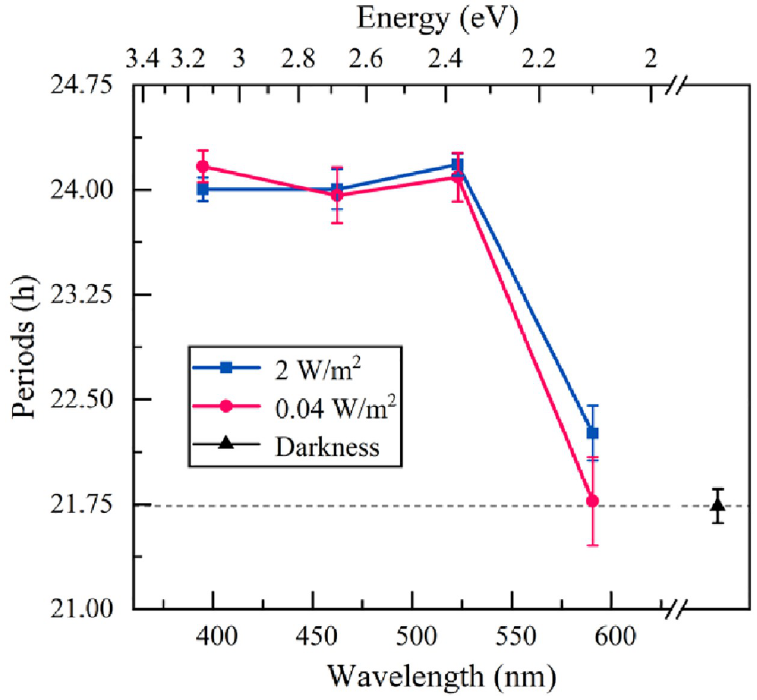
Fig 3. The results of circadian rhythm periods (Mean ± SEM). The violet, blue, and green light can modulate the circadian rhythm of the sample from 21.7 hours to around 24 hours, but that yellow light weakens the modulating effect. Both the circular and square points from the left to right represent the violet, blue, green and yellow light. The black triangle is the control group.